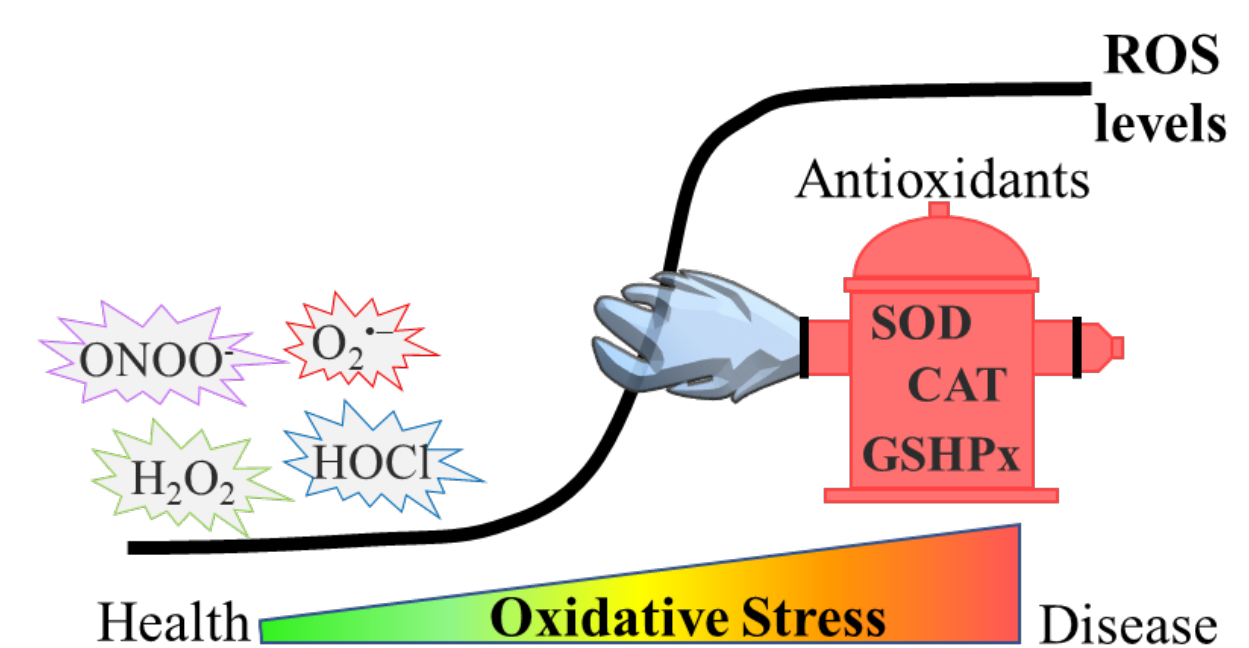
Figure 1. Development of oxidative stress. In physiological conditions, ROS remain at low levels by the effect of antioxidants such as superoxide dismutase (SOD), catalase (CAT) and glutathione peroxidase (GSHPx). However, during oxidative stress, ROS levels rise, due to either higher production or impaired antioxidant defense (or both), and this results in the accumulation of damaged biomolecules. Such events are detrimental and either drive or exacerbate diseases such as neurodegenerative disorders.